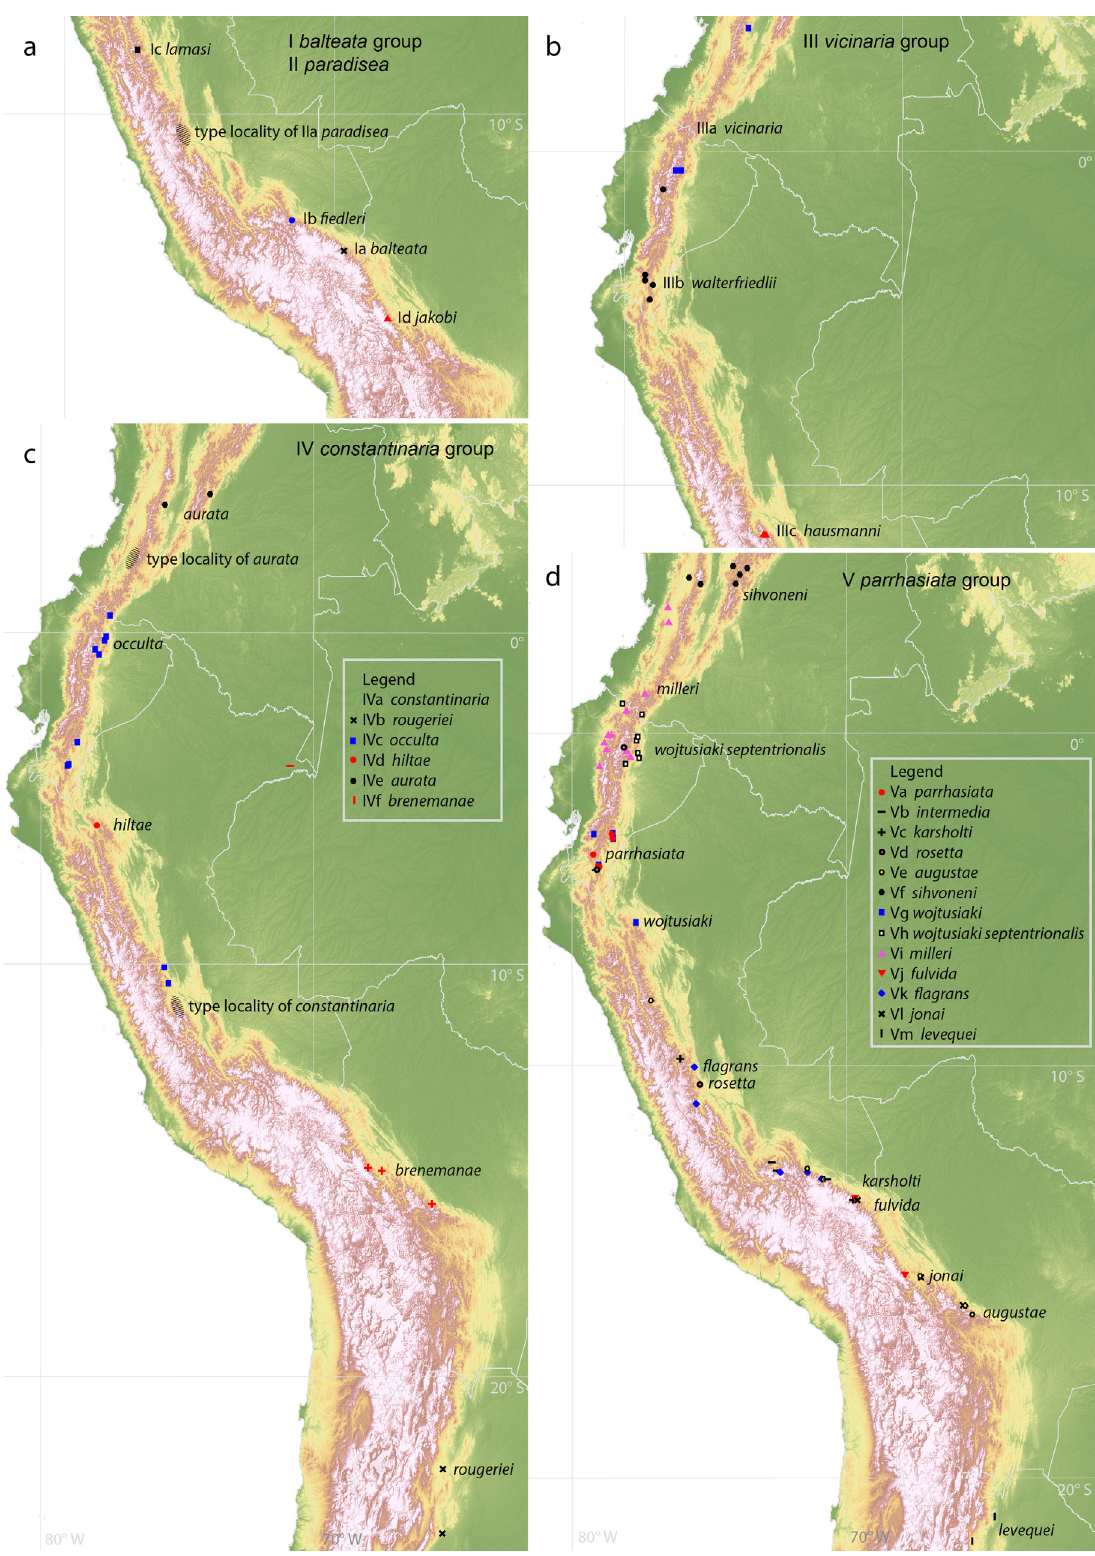
Fig. 2. Distribution maps. A . The balteata group and Callipia paradisea Thierry-Mieg, 1904. B . The vicinaria group. C . The constantinaria group. D . The parrhasiata group. More details can be retrieved from a Google Earth kml file ( Supplementary File